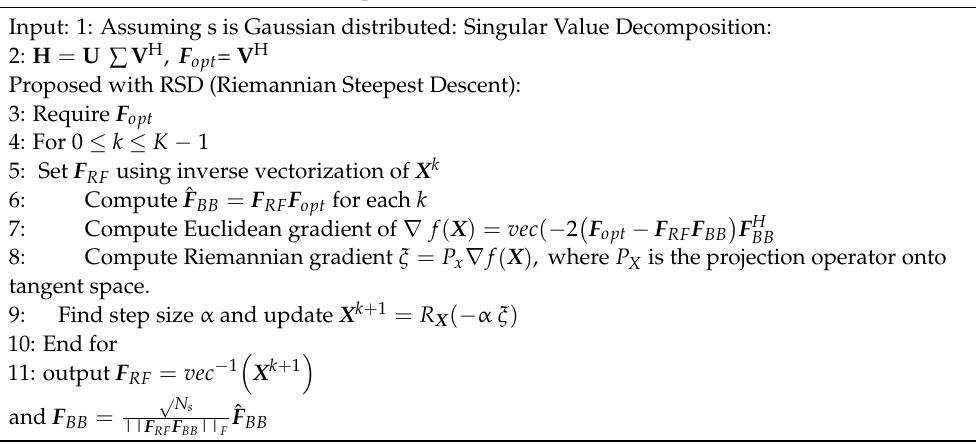
Algorithm 1 RSD (Riemannian Steepest